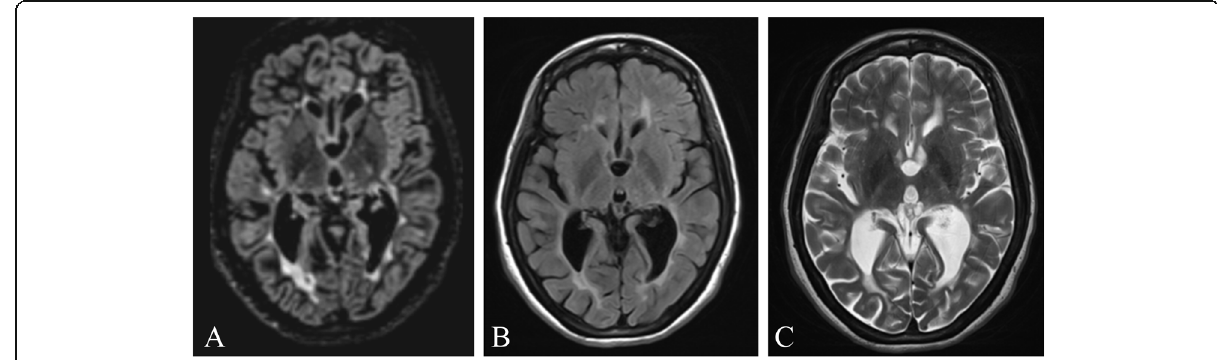
Fig. 3 Note the numerous confluent periventricular MS plaques in a RRMS patient with EDSS2 and numbness and dysfunction. DIR ( a ), FLAIR ( b ), and T2W_TSE ( c ). DIR image showing more counted lesions with sharply defined borders compared to FLAIR and